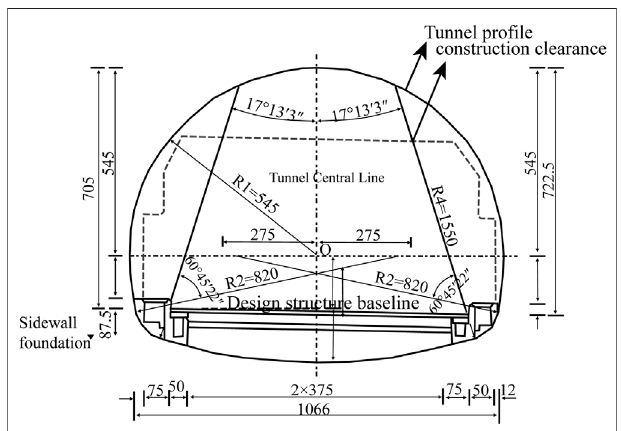
FIGURE 1 | Outline of the main tunnel.